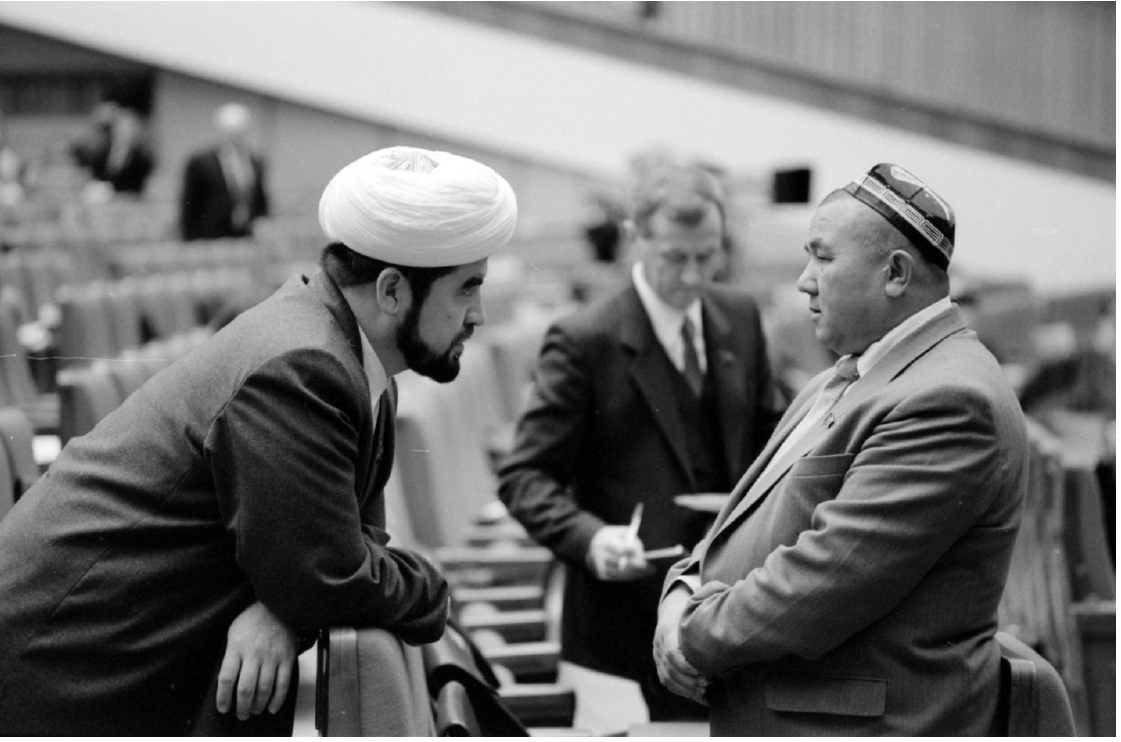
Figure 2 Deputies of the Third (Extraordinary) Congress of People’s Deputies of the USSR Mukhammad-Iusuf Mukhammad-Sodik, Chairman of the Spiritual Board of the Muslims of Central Asia and Kazakhstan, and Mamatgazi Shergaziev, Сhairman of the Collective Farm “Leningrad” of the Fergana Region of Uzbekistan, talking during a break between sessions. Moscow, March 13, 1990. From the collection of the RGAKFD, Krasnogorsk, Item